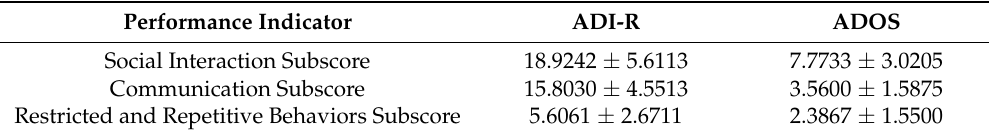
Table 2. Indicators of performance of ASD subjects in different fields of behavior that allow clinicians to better evaluate the